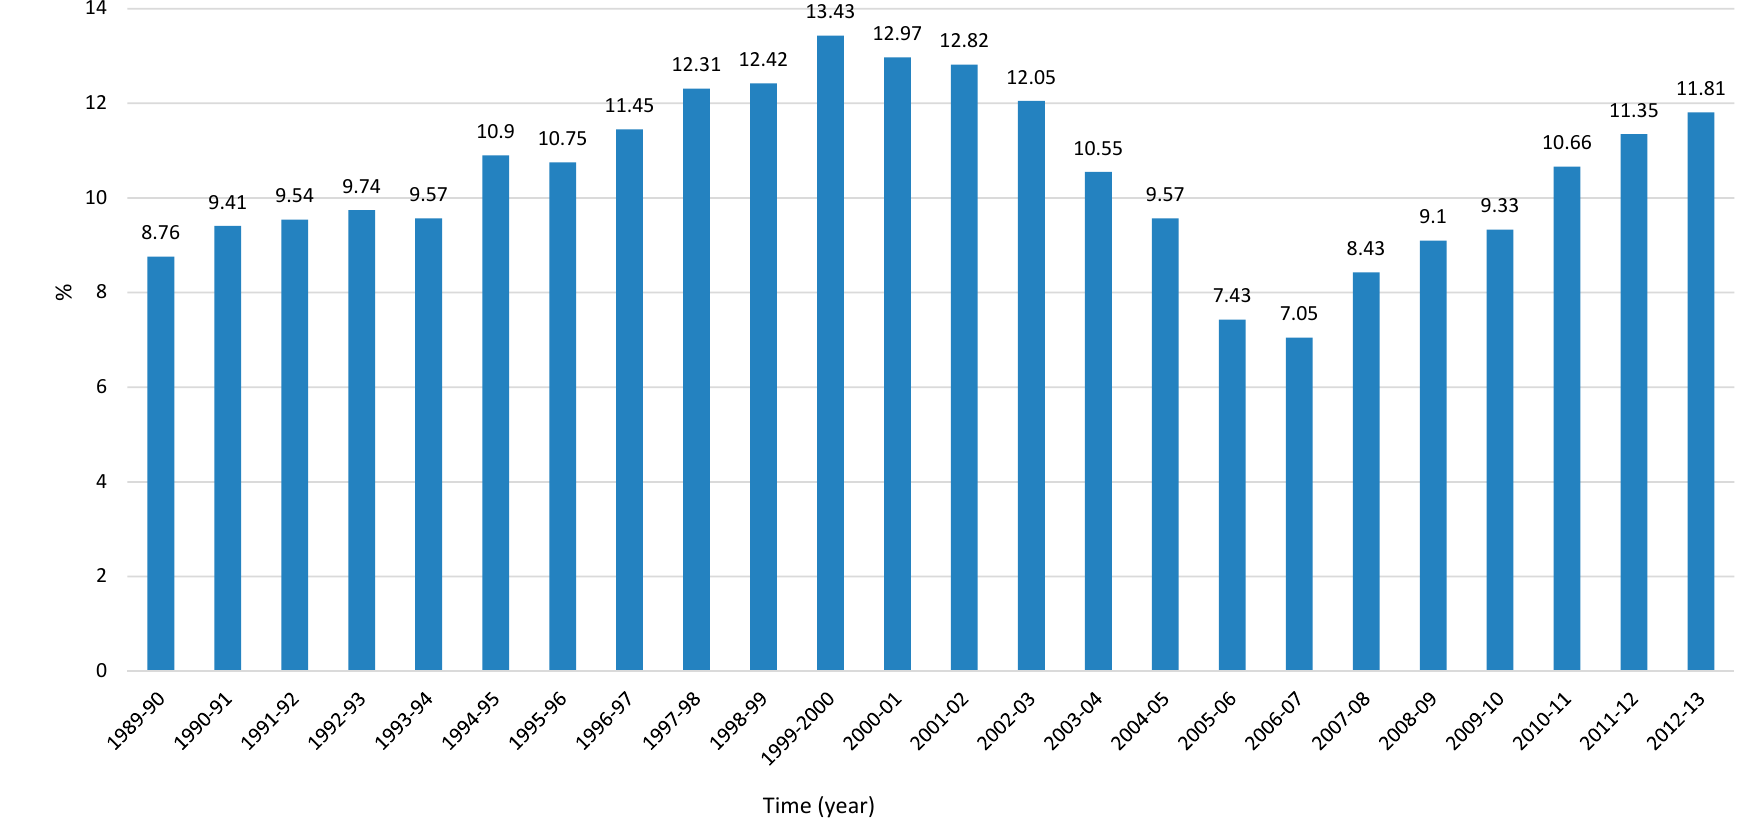
Figure 5. Yearly uncertainty in energy data.